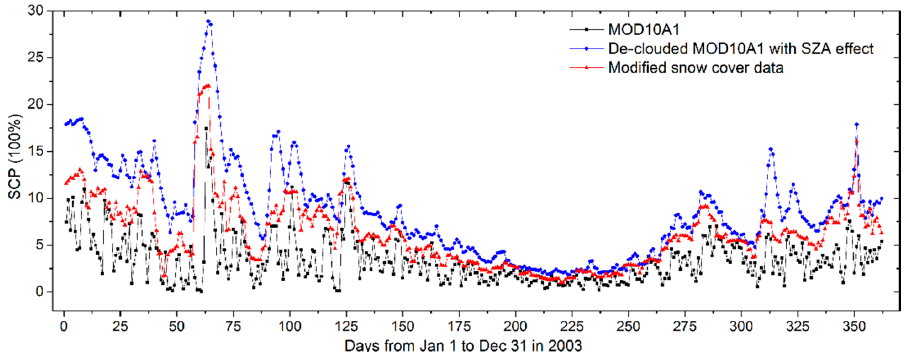
Figure 8. Comparison of the snow cover percentage (SCP) values from the MOD10A1, de-clouded MOD10A1 with sensor zenith angle (SZA) effect, and modified snow cover data for each day in 2003. The SCF data for the 10 years between 2002 and 2011 were also used to evaluate the SZA effect.